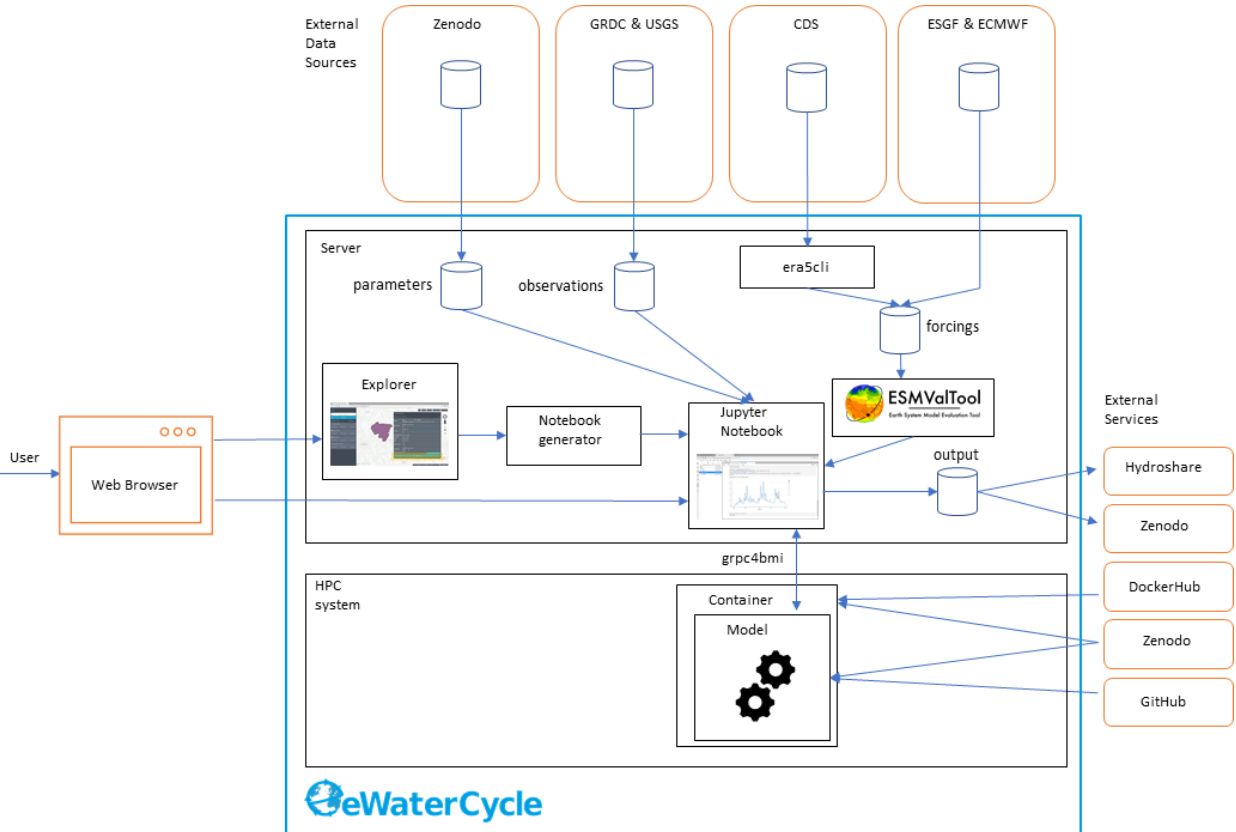
Figure 2. The technological design of the eWaterCycle platform, including external services. This overview shows the different components that are, on purpose, built as separate entities to facilitate reuse in other projects. The different components of this technical overview are discussed in detail in the main text of this